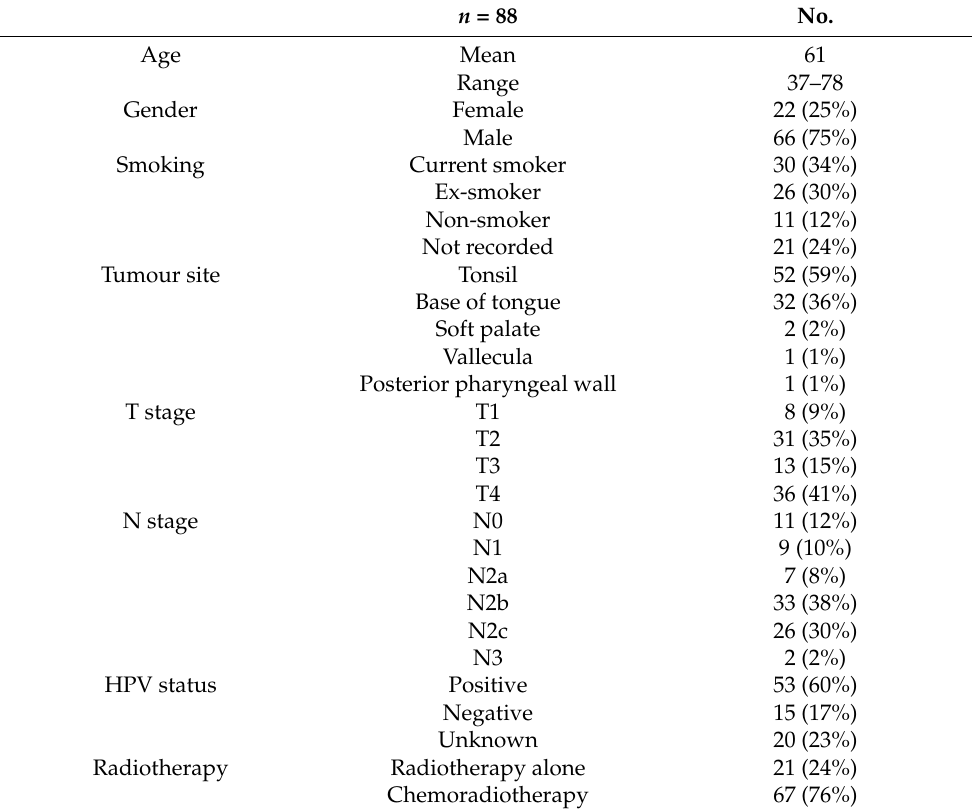
Table 1. Patient cohort